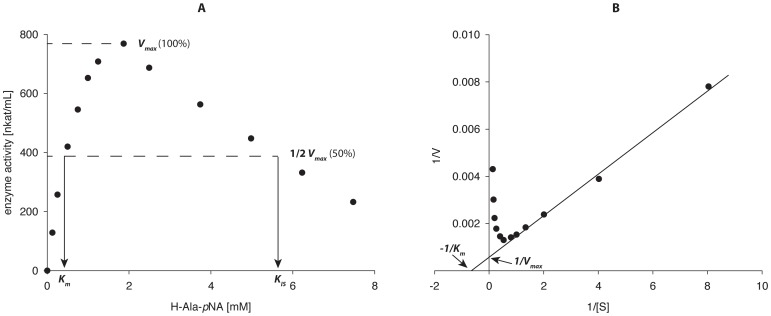
Determination of the kinetic parameters of PepN for the substrate H-Ala-pNA according to Michaelis-Menten analysis (A) and Lineweaver-Burk linearization (B) (each point represents the average of triplicate measurements; the standard deviation was <5%).